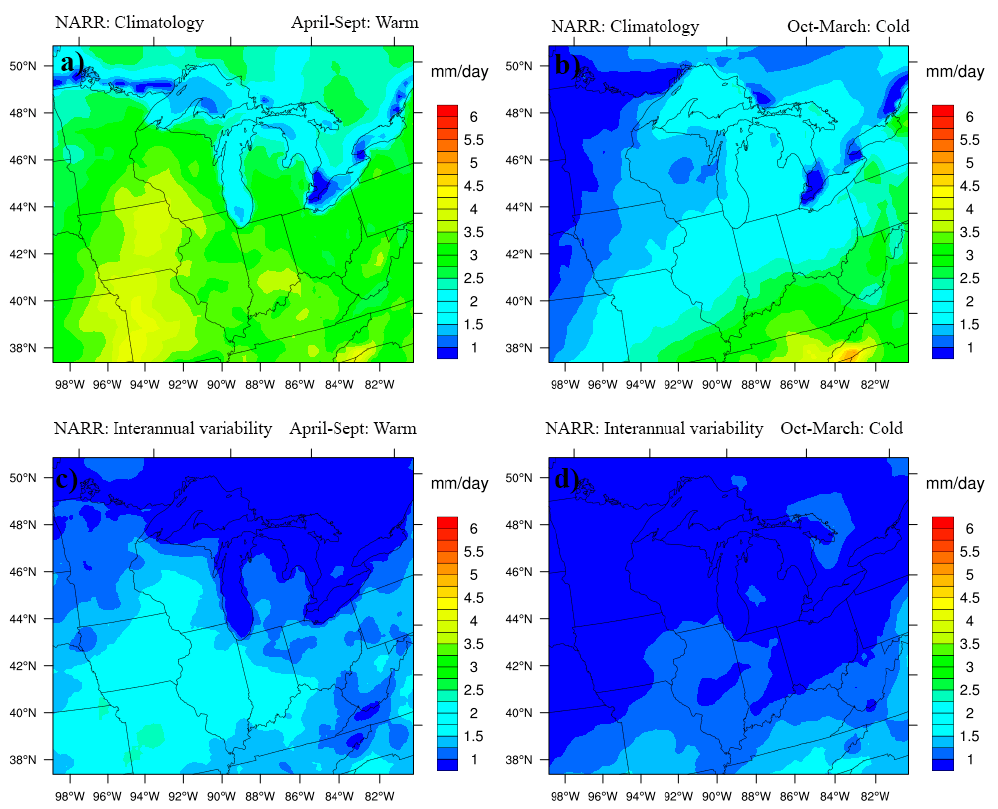
Figure 3. Same as Figure 2 but for North American Regional Reanalysis (NARR) data.